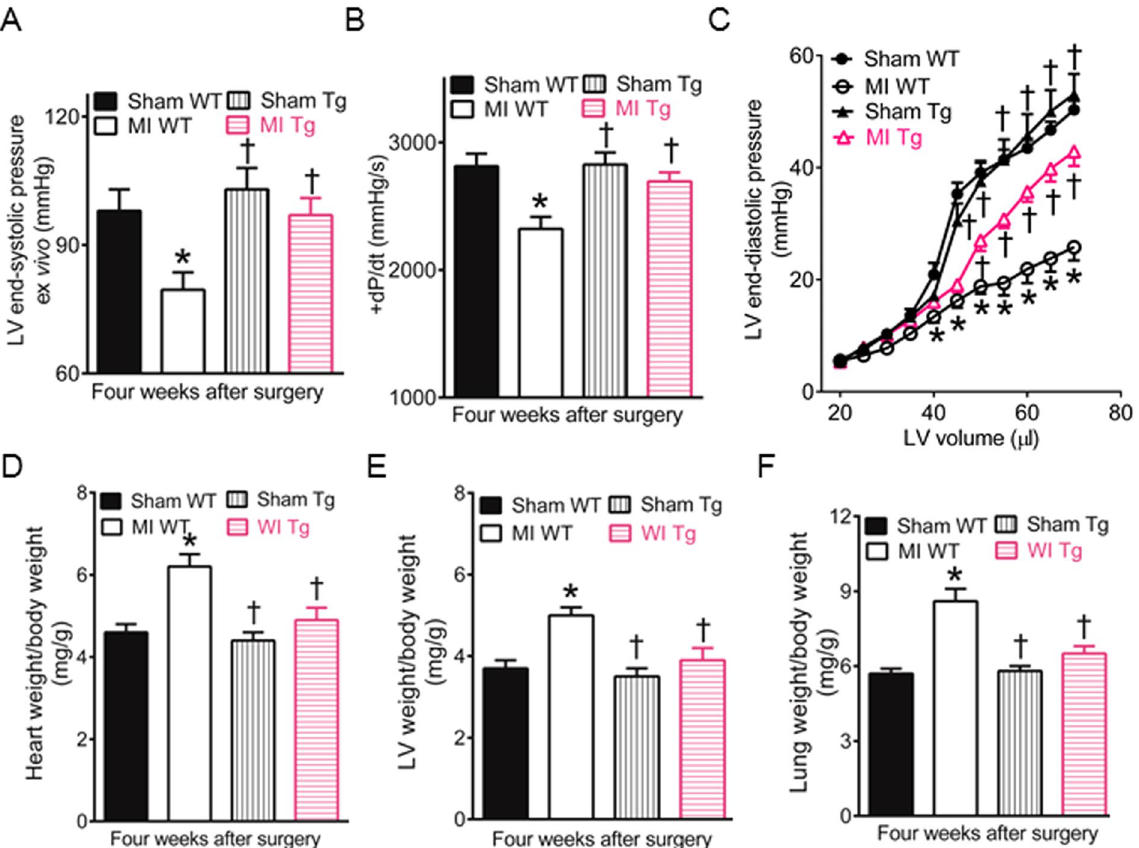
Figure 5. GTP cyclohydrolase 1 (GCH1) overexpression improves cardiac function 4 weeks after myocardial infarction (MI). ( A ) Left ventricular (LV) end-systolic pressure; ( B ) The rate of LV pressure rise ( + dP/dt); ( C ) The LV end-diastolic pressure-volume relationship; ( D ) Heart weight normalized to body weight; ( E ) LV weight normalized to body weight: ( F ) Lung weight normalized to body weight. Figure legend: sham WT, wild-type mice receiving sham surgery; MI WT, wild-type mice undergoing myocardial infarction; sham Tg, transgenic GCH1 mice receiving sham surgery; MI Tg, transgenic GCH1 mice undergoing myocardial infarction. * P < 0.05 versus sham WT groups; † P < 0.05 versus MI WT groups (n = 8–10